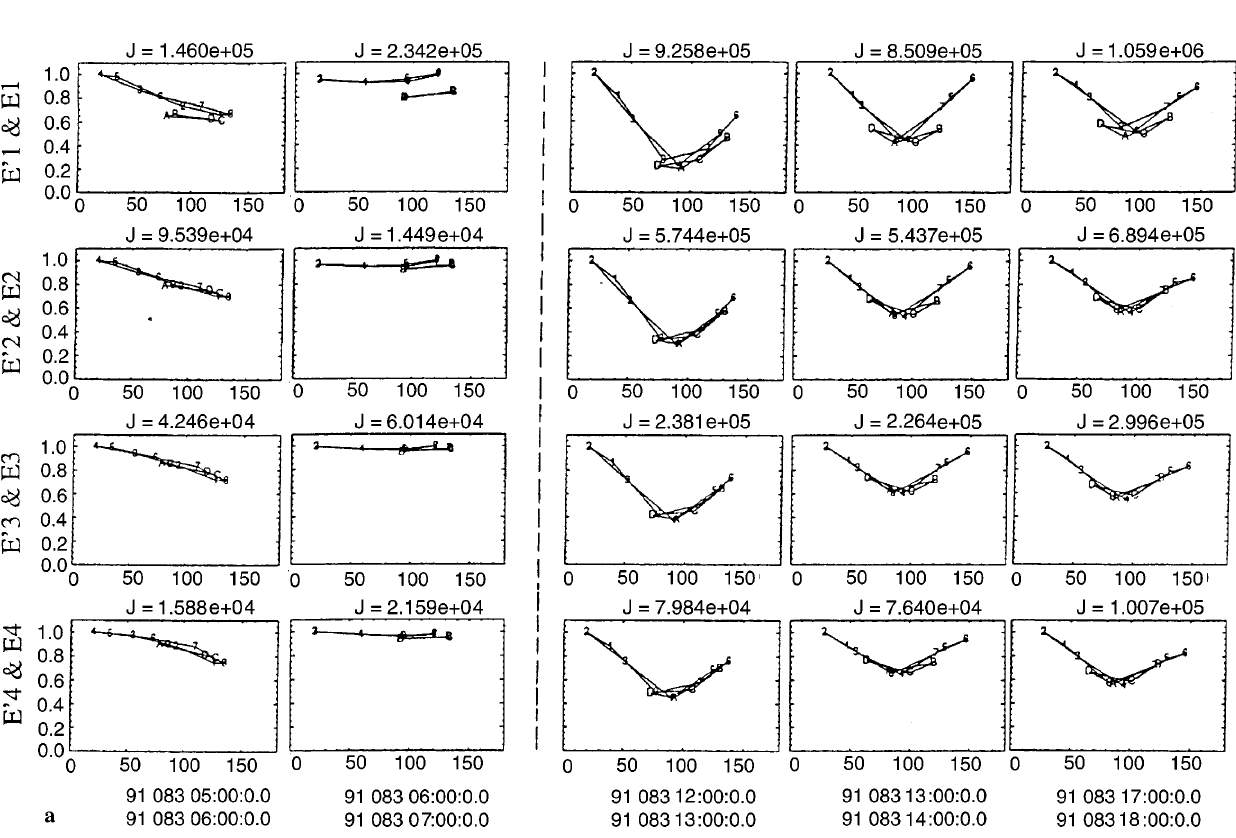
Fig. 2 a. The first two columns in this figure present electron pitch angle distributions detected before Ulysses entered the first ICME. The three subsequent columns are representative of pitch angle distribution snapshots for the trapped electron population observed in region A . Evidently, electron pitch angle distribution